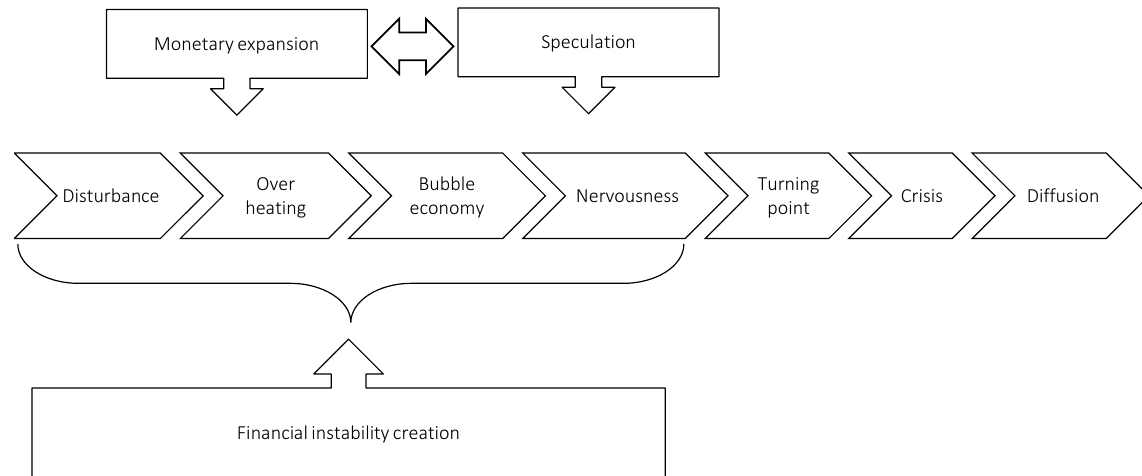
Figure 1. Seven-step dynamic model for financial